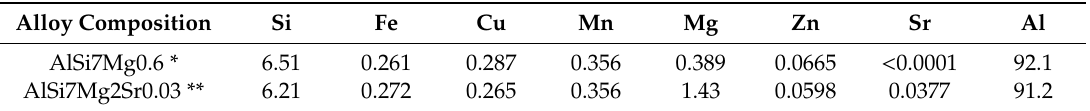
Table 1. Chemical composition of EN AC 42200 (AlSi7Mg0.6) commercial alloy and matrix alloy after modification with Mg and Sr additives.